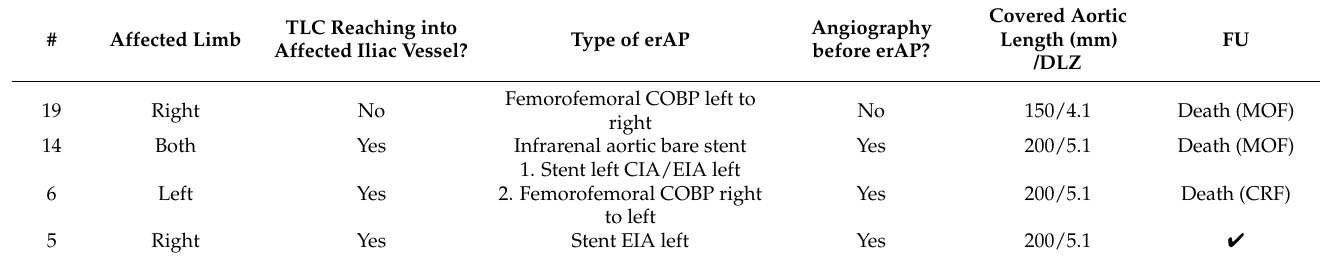
Table 3. Extremity-related adjunct